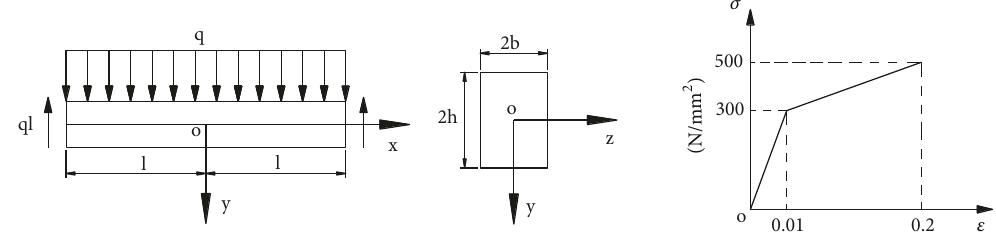
Figure 4: The numerical model and material property in